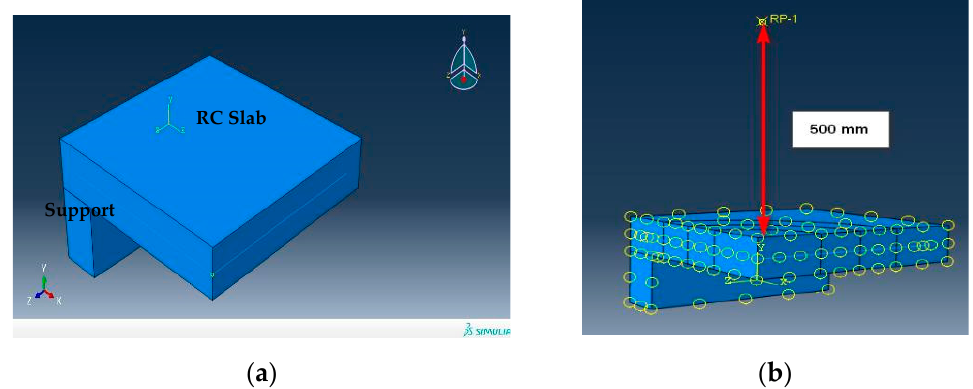
Figure 7. FE modeling of the slab: ( a ) modeling in Abaqus for validation; ( b ) blast loading in Conwep.